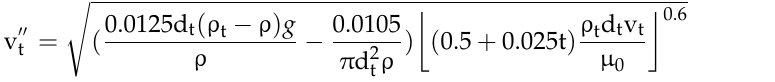
Table 3. Comparison of model